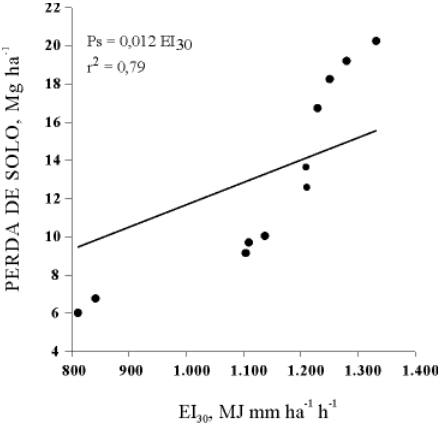
Figura 1. Relação das perdas de solo (PS) com a erosividade das chuvas simuladas aplicadas (EI ) sobre um Nitossolo Háplico alumínico. A 30 significância da relação está baseada no intervalo de confiança (IC) de 95 %. (0,0097 < IC